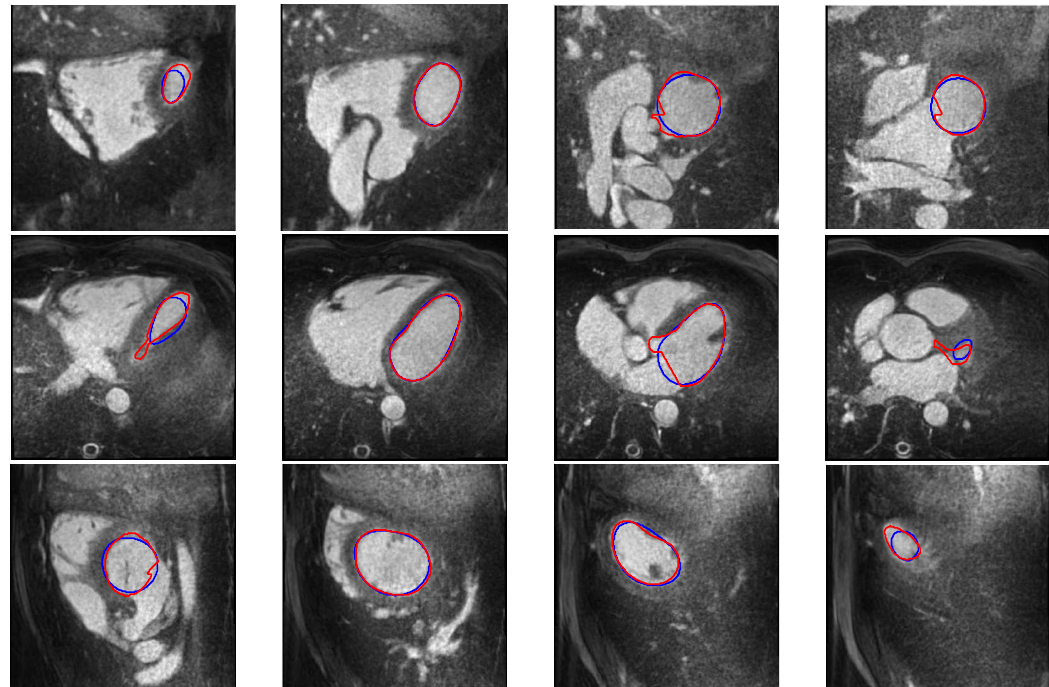
Figure 9. The 3D interpolation evaluation results: ( a ) the A-HRBF result with average Dice coefficient of 0.91, 0.95, and 0.96 for one, three, and five slices per orientation, respectively; ( b ) the HRBF result with average Dice coefficient of 0.69, 0.63 and 0.69 for one, three, and five slices per orientation, respectively.